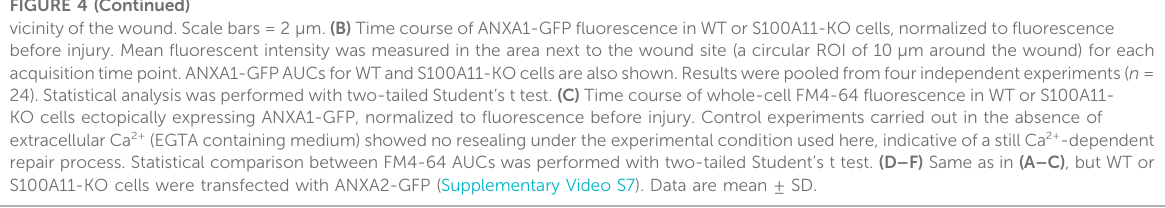
(Supplementary Figure S6B,C) indicating that deletion of S100A11 is not compensated by an upregulation of ANXA1 or ANXA2 expression